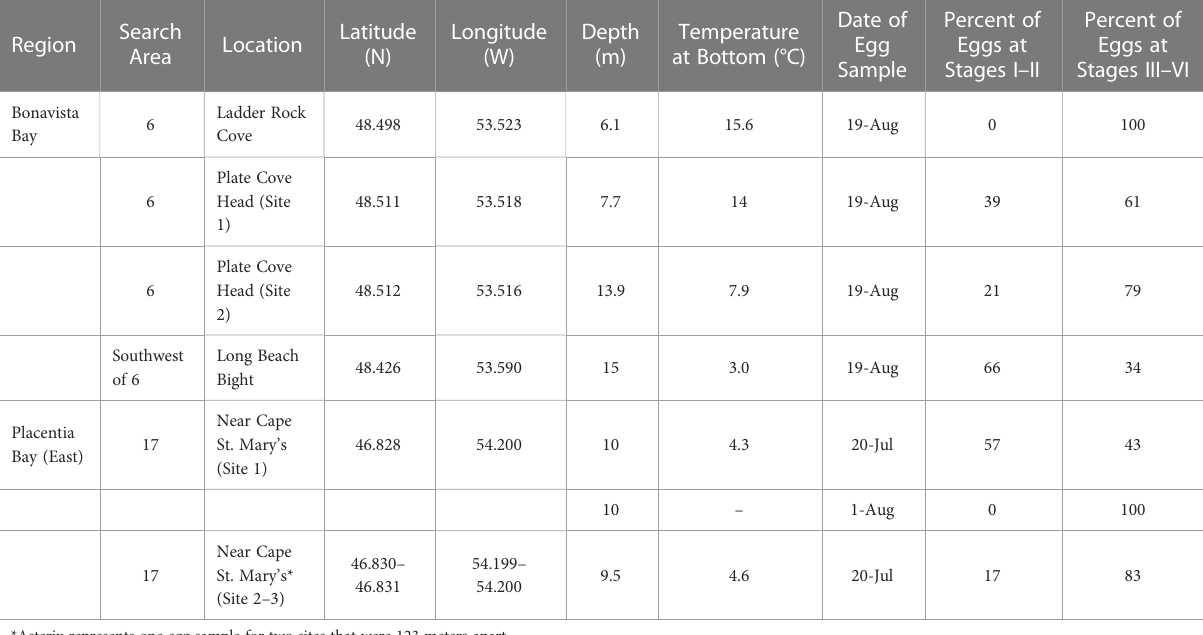
*Asterix represents one egg sample for two sites that were 123 meters apart. Total percent ofeggs is the number of eggs per category divided by the total number of live eggs. No abnormallyformed or dead eggs were observed in any of these samples. Note Near Cape St. Mary ’ s (Site 1) was sampled two times, 20 Jul and 1 Aug 2019. Location of search areas indicated on Figure